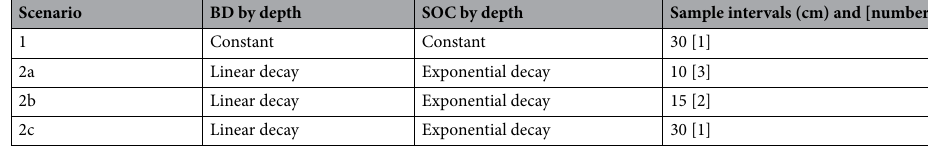
Table 2. Hypothetical ESM scenarios showing variation with depth for bulk density (BD) and soil organic carbon (SOC) at each sampling time point, along with the sample depth intervals investigated.